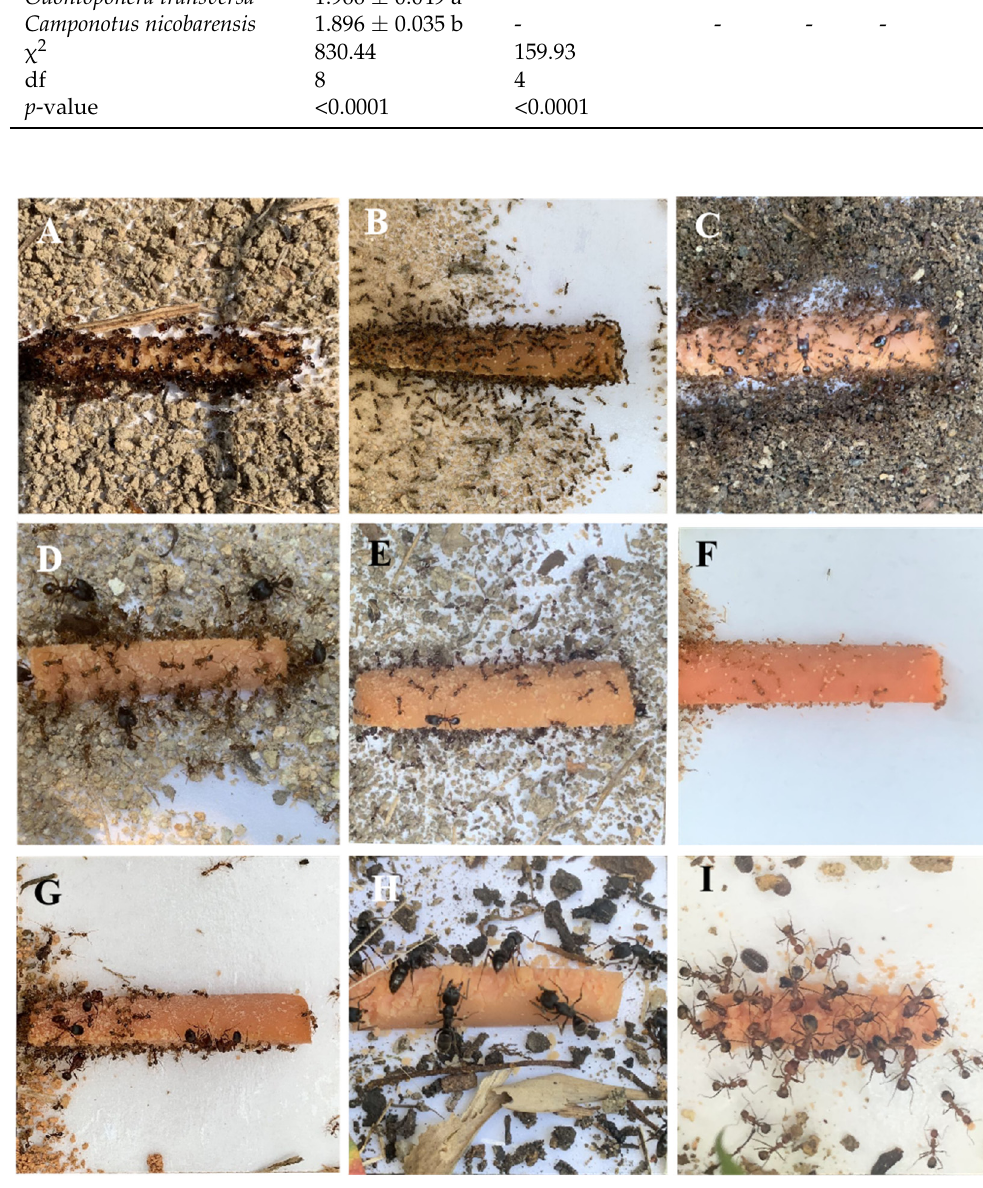
Table 6. Results of linear regression models with particle size as dependent variable and ant head width as independent variable for each species. Species